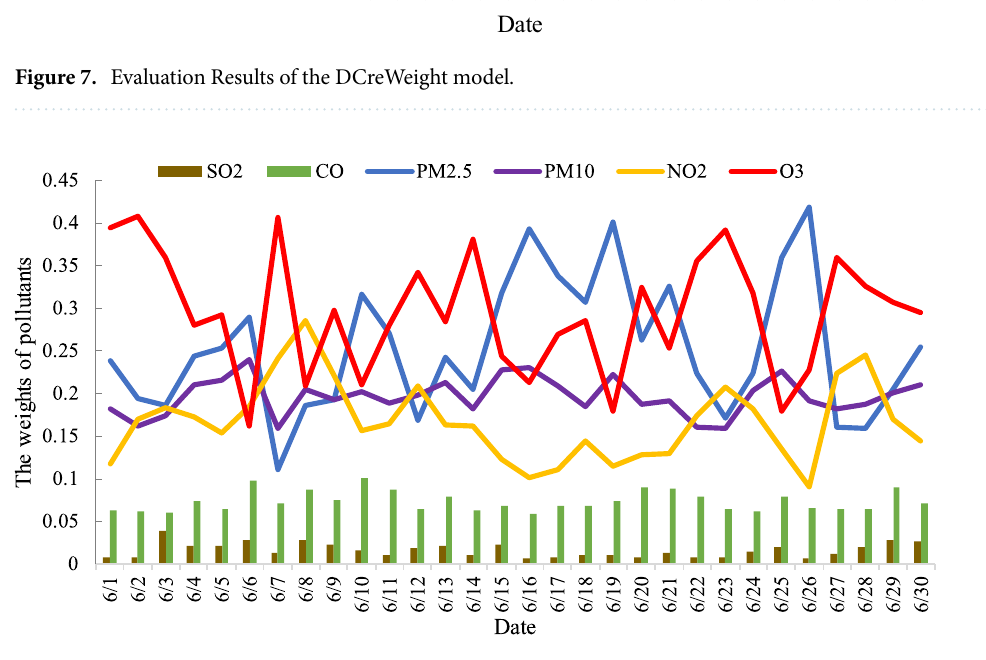
Figure 8. The weights of pollutants in